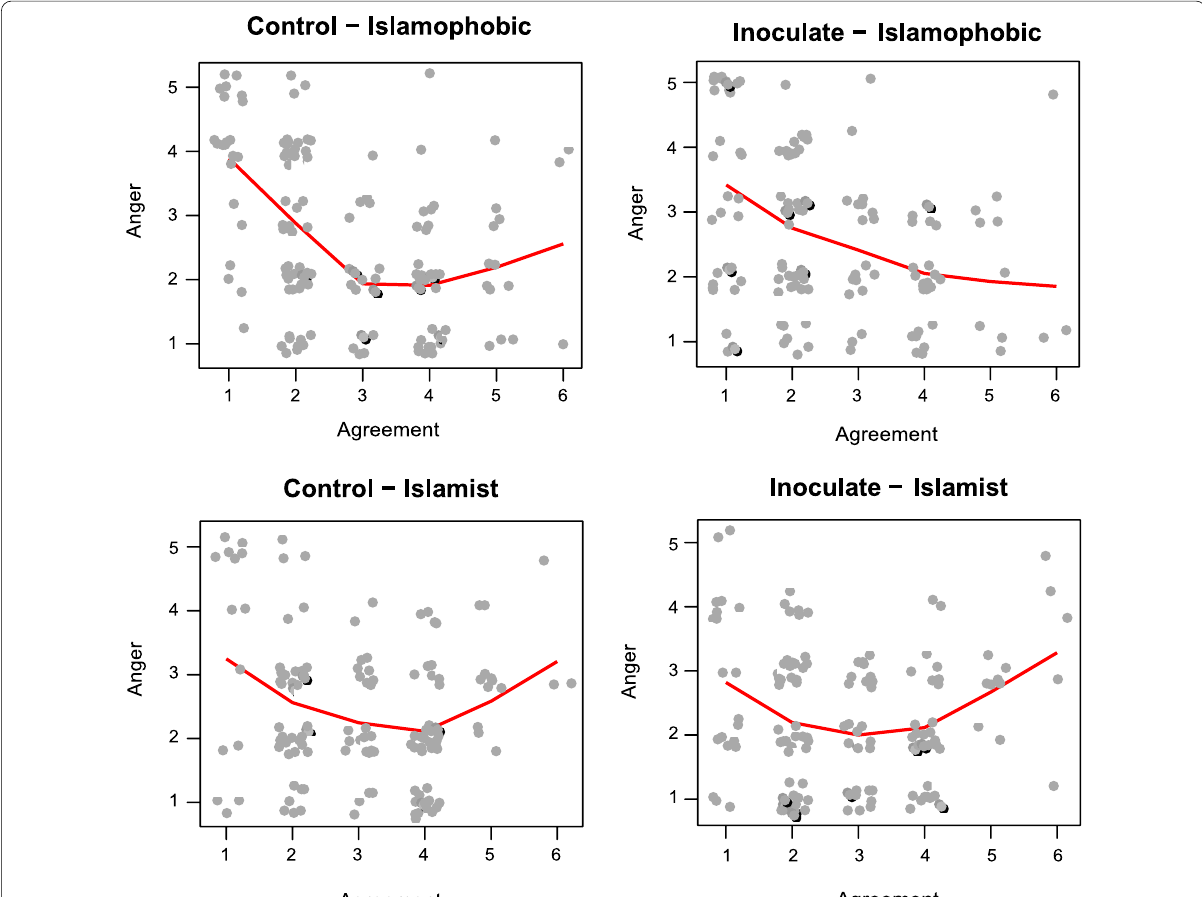
Fig. 4 Relationship between anger and agreement with the video in the 4 conditions. All points are jittered to avoid overprinting. The red lines represent lowess